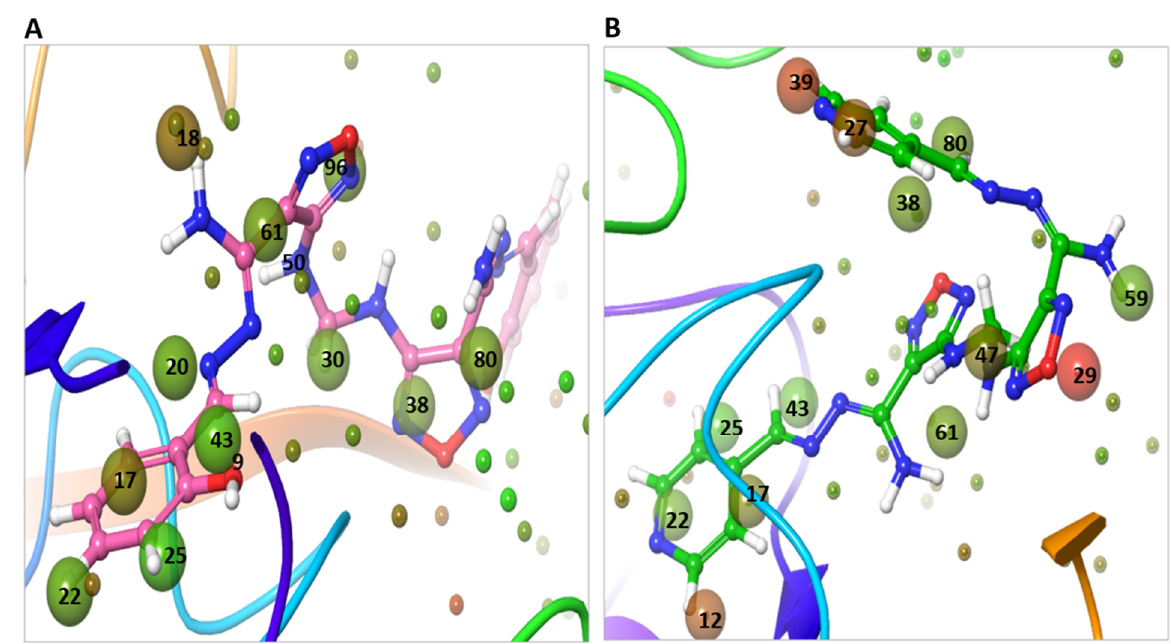
Figure 16. WaterMap analysis of the hydration sites of TMPRSS2 binding pocket with the docked pose of compounds. ( A ) The overlay and displacement of unstable and replaceable water with Compound 13 . ( B ) The overlay and displacement of unstable and replaceable water with M3 . The hydration sites were shown with small spheres. The color spectrum ranged from red (most unfavorable) to green (least unfavorable).